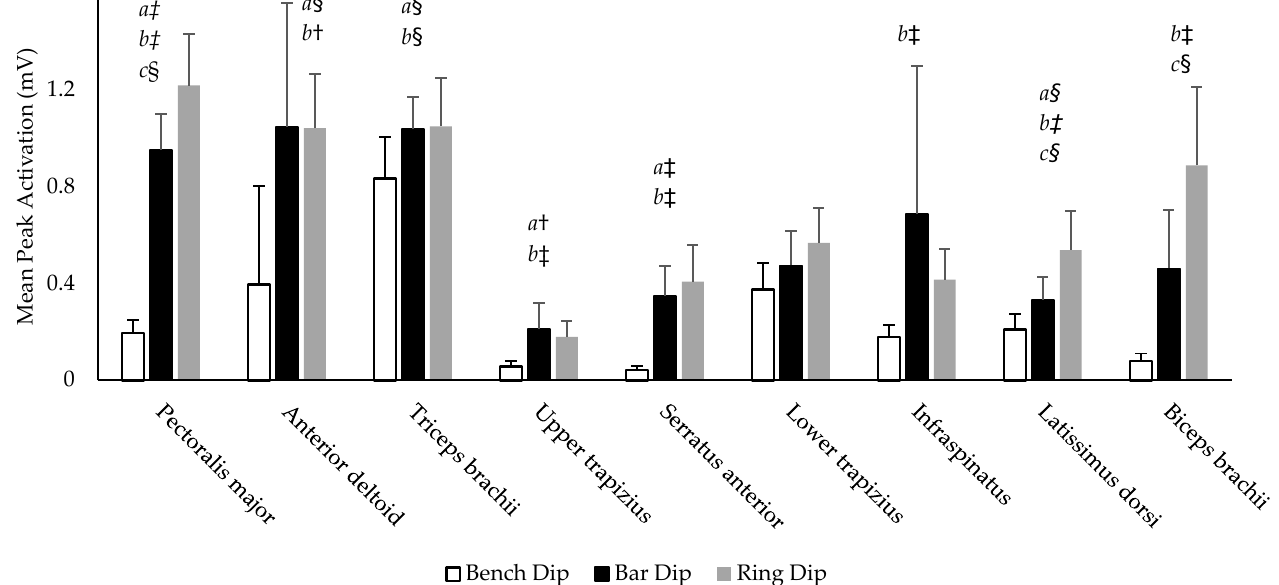
Figure 4. Mean peak sEMG amplitudes during the bench, bar, and ring dips. a = significant difference between the bench dip and bar dip, b = significant difference between the bench dip and ring dip, c = significant difference between the bar dip and ring dip. § indicates medium effect size ( d > 0.5), † indicates large effect size ( d > 0.8), ‡ indicates very large effect size ( d > 1.2) .